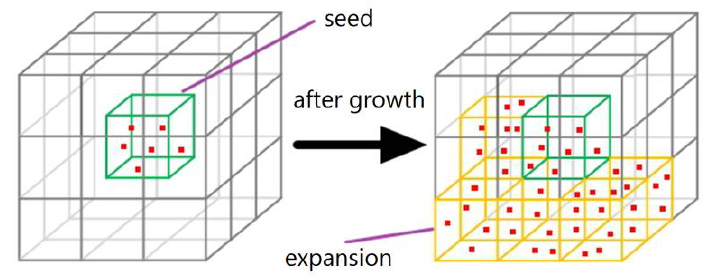
Figure 6. Box-counting dimension calculation sketch map.